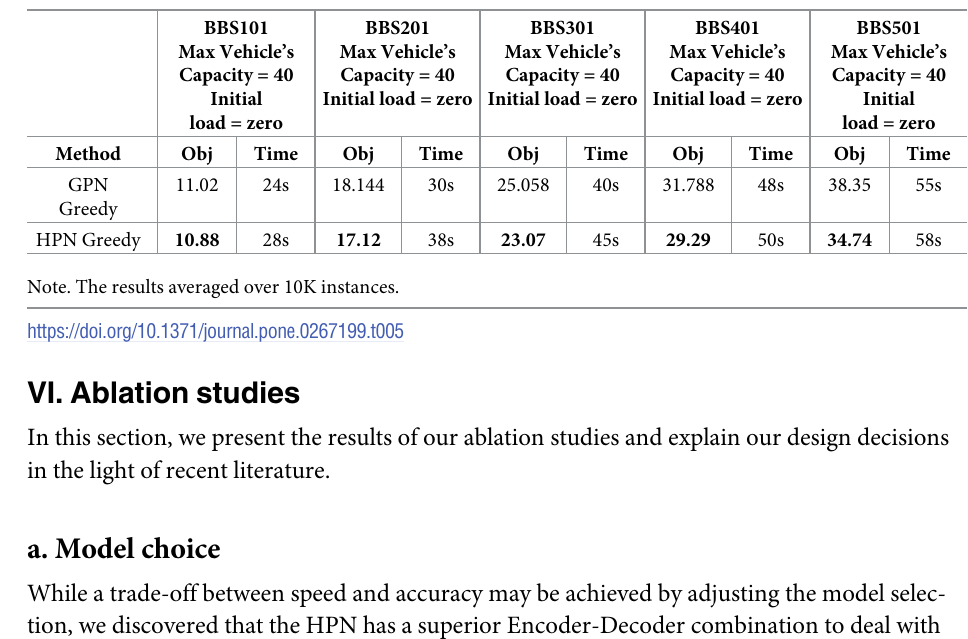
Table 5. Results of BBS101, BBS201, BBS301, BBS401, and